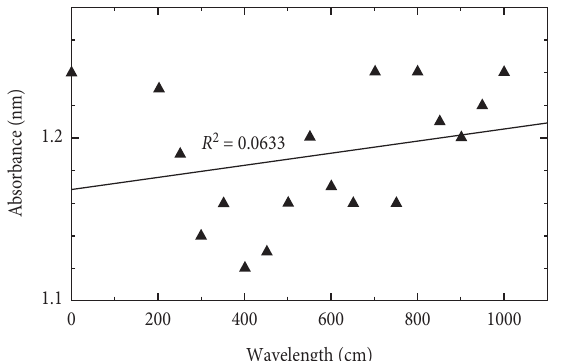
Figure 5: Ultraviolet-visible spectrophotometric graph of NQF